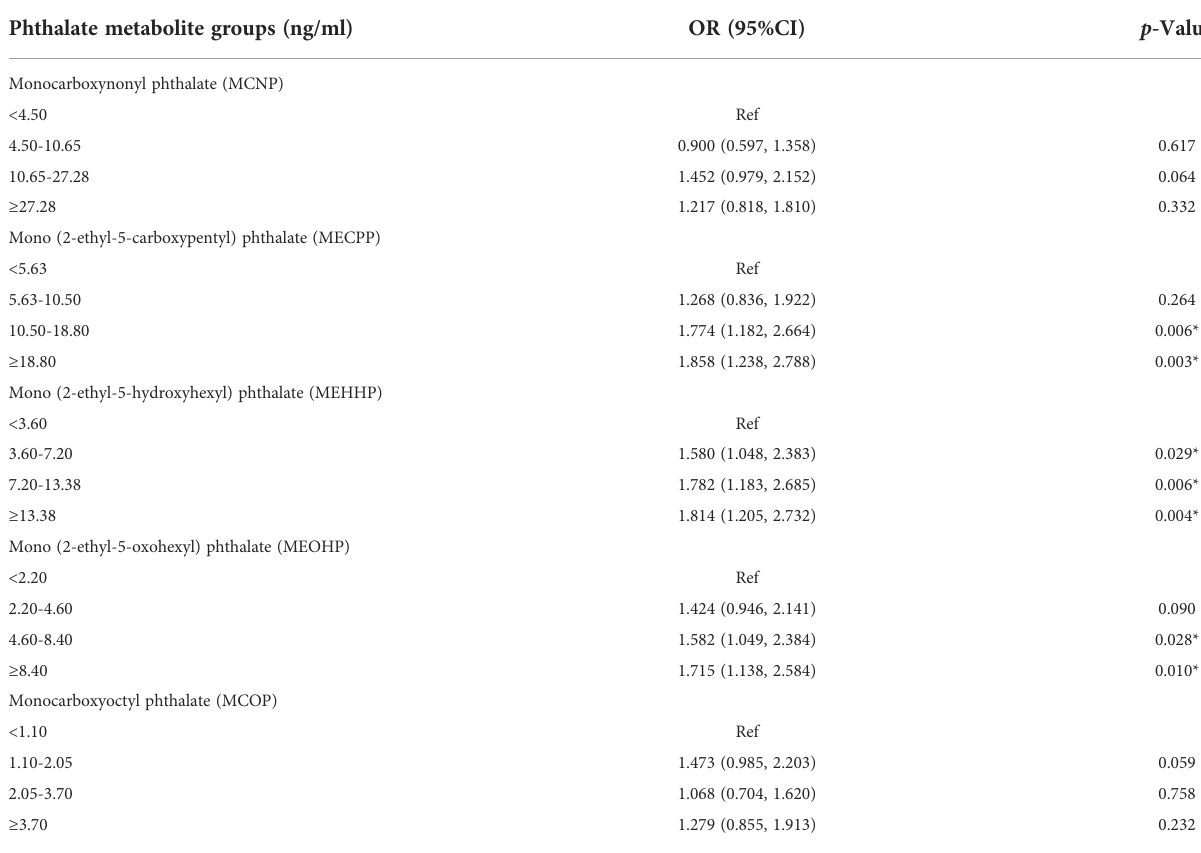
TABLE 6 Multivariable regression analysis adjusted with age, PIR and BMI. Phthalate metabolite groups